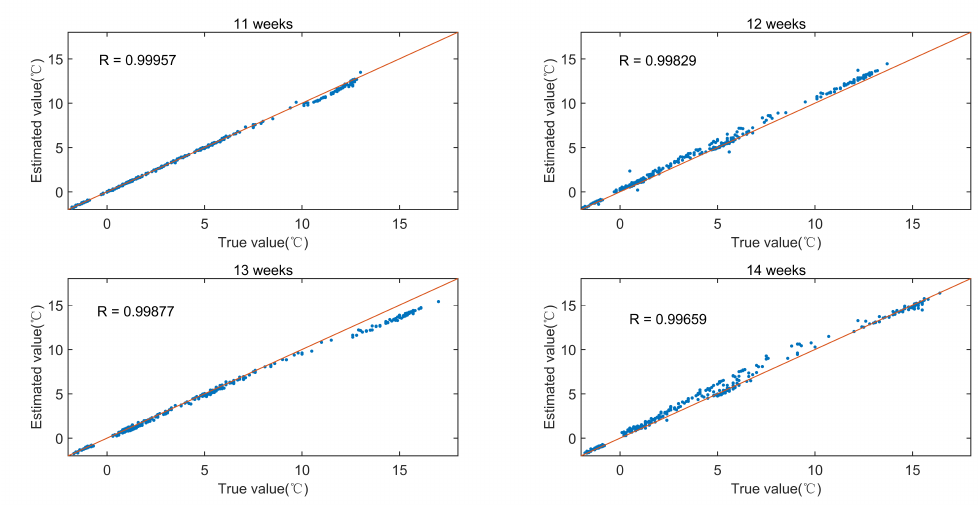
Figure 11. Prediction against sampled points for all real